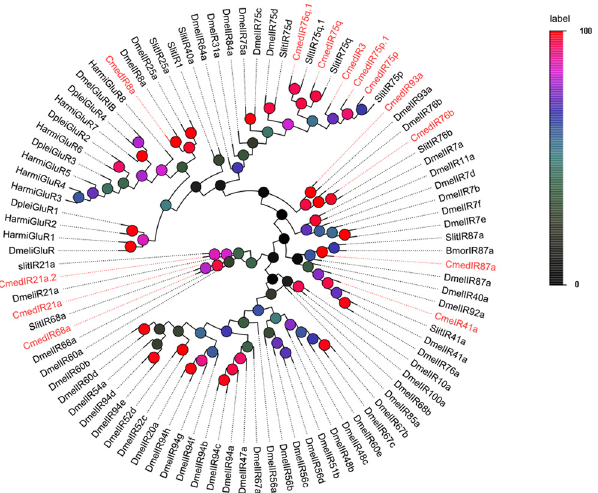
Fig 3. Phylogenetic tree of candidate CmedIRs with known IR sequences of other species. Harm: H . armigera ; Hvir: Bmor: B . mori ; Slit: Spodoptera littoralis , Dmel: Drosophila melanogaster .